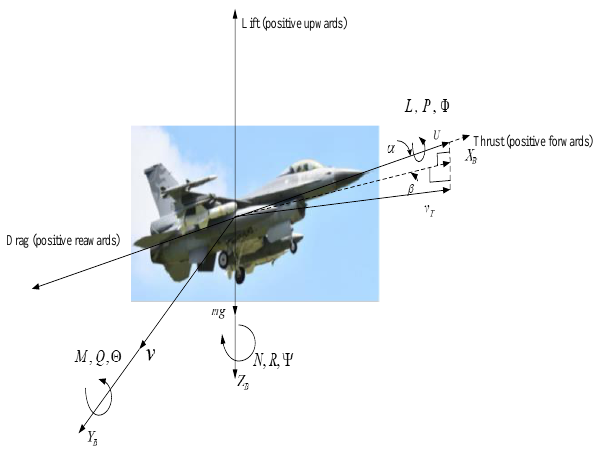
Figure 1. Moments, Euler Angles and Velocities of